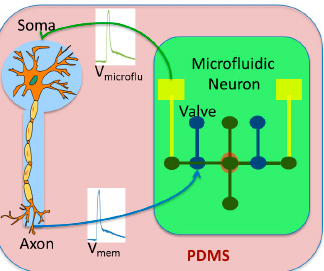
Figure 4. A single chip representation of a hybrid experiment using microfluidic neuron. Neuron stimulation is made from a microfluidic neuron electrode. The control of the microfluidic neuron valve is done by the electrical activity of “in vitro” neurons. V mem is the action potential of the biological neuron, V microflu is the action potential of the microfluidic neuron.